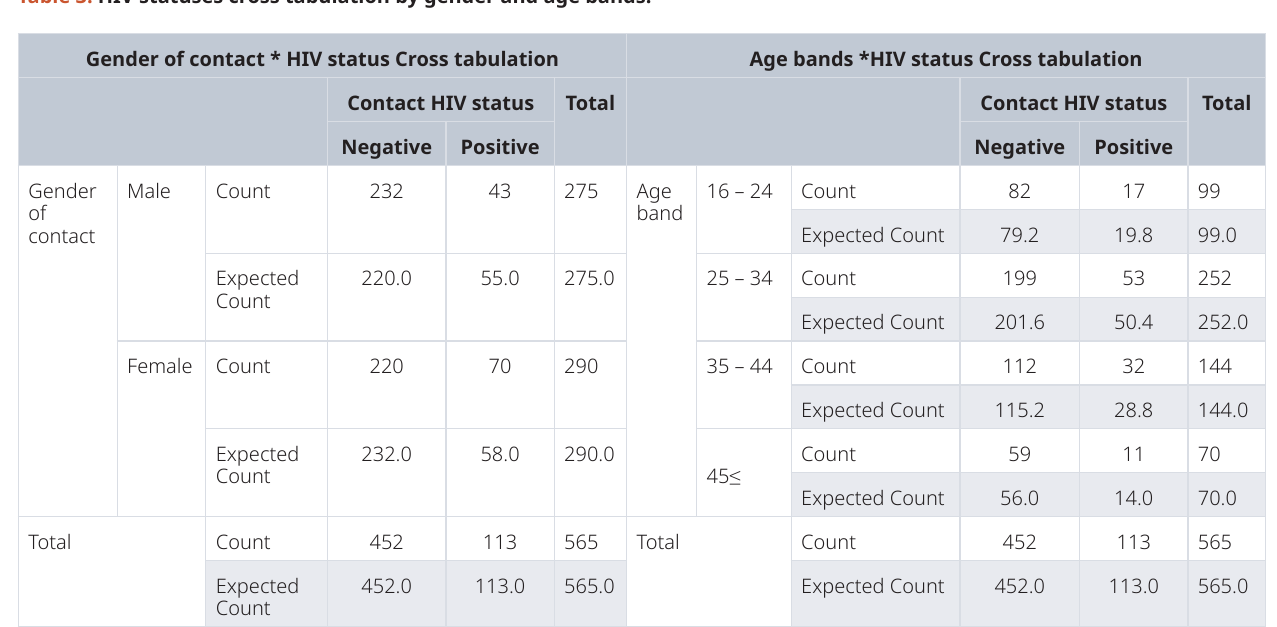
Table 3. HIV statuses cross tabulation by gender and age